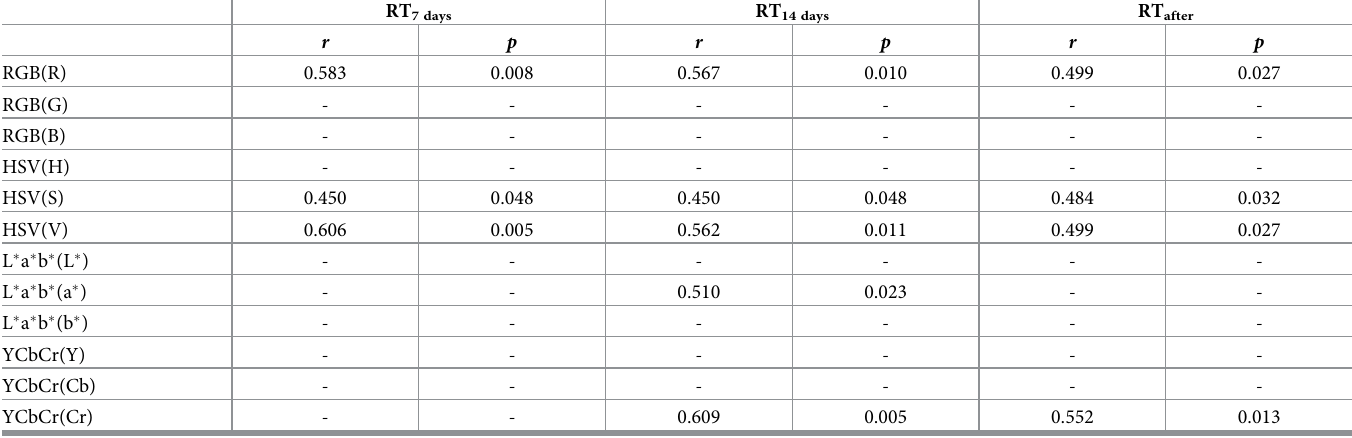
Table 5. Correlation coefficients ( r ) with corresponding p -values for Spearman’s rank correlation test between skin dose values and the values of the color space parameters for irradiated breasts. RT 7